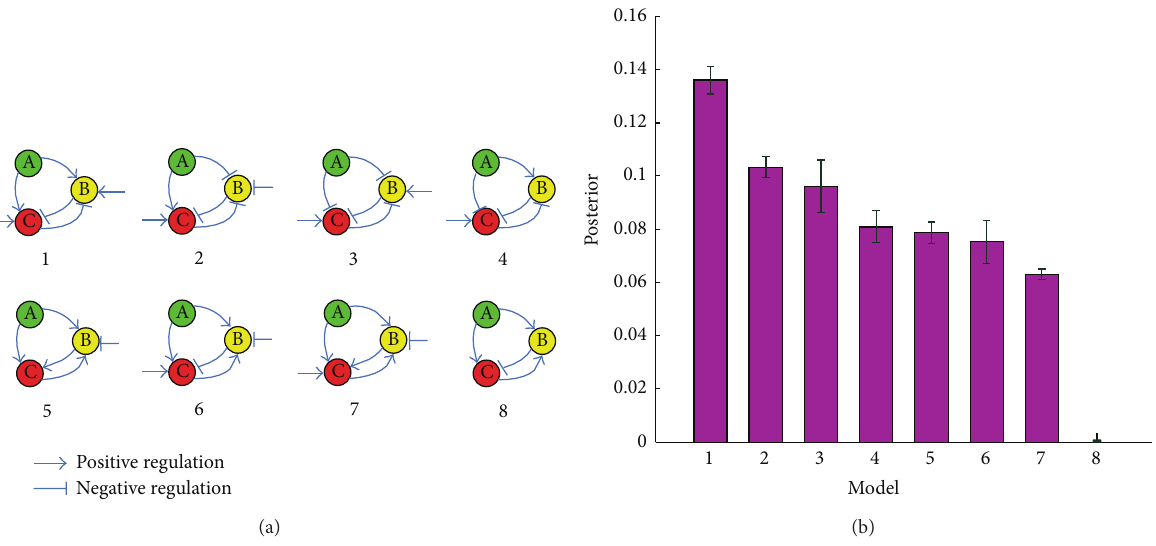
Figure 2: (a) 1–7: the top seven biological circuits. 8: a biological circuit ranked bottom. (b) Posterior probability for buffering noise while maintaining sensitivity. The error bars indicate the variability in the marginal model posteriors over 10 separate